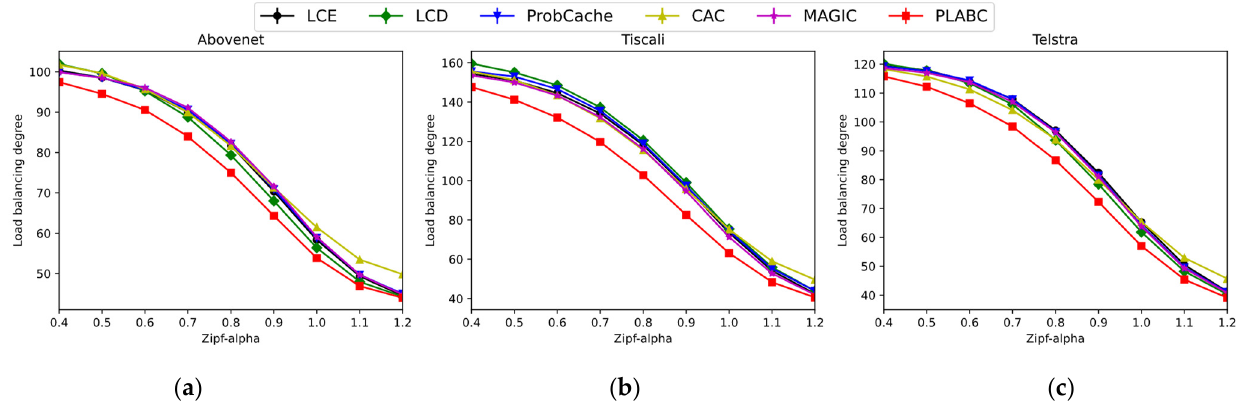
Figure 16. Load balancing degree results of different caching strategies when Zipf exponent alpha varies under topology: ( a ) Abovenet; ( b ) Tiscali; ( c ) Telstra.